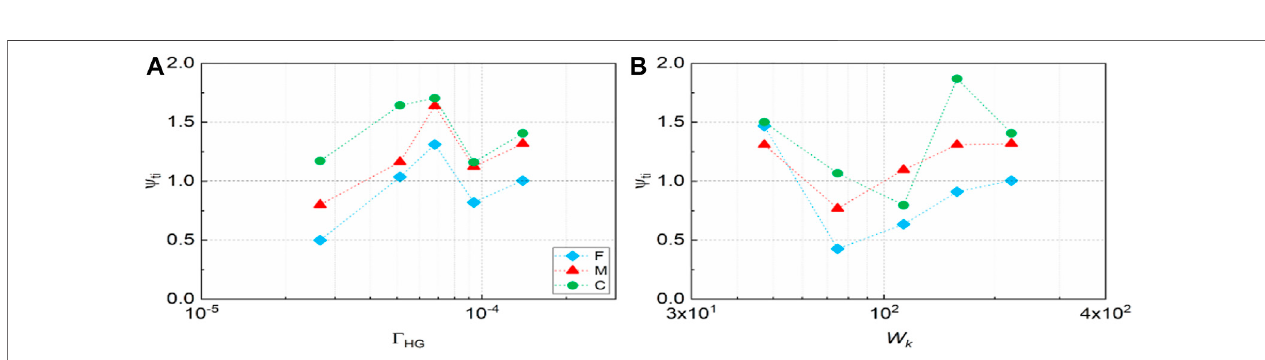
FIGURE 8 | Bed load yield ratios ψ ti for fi ne F , medium M and coarse C size classes obtained plotted in (A) Γ HG -varying ( i.e., group U1, Table 1) and (B) W k -varying ( i.e., group V1, Table 1) hydrograph fl